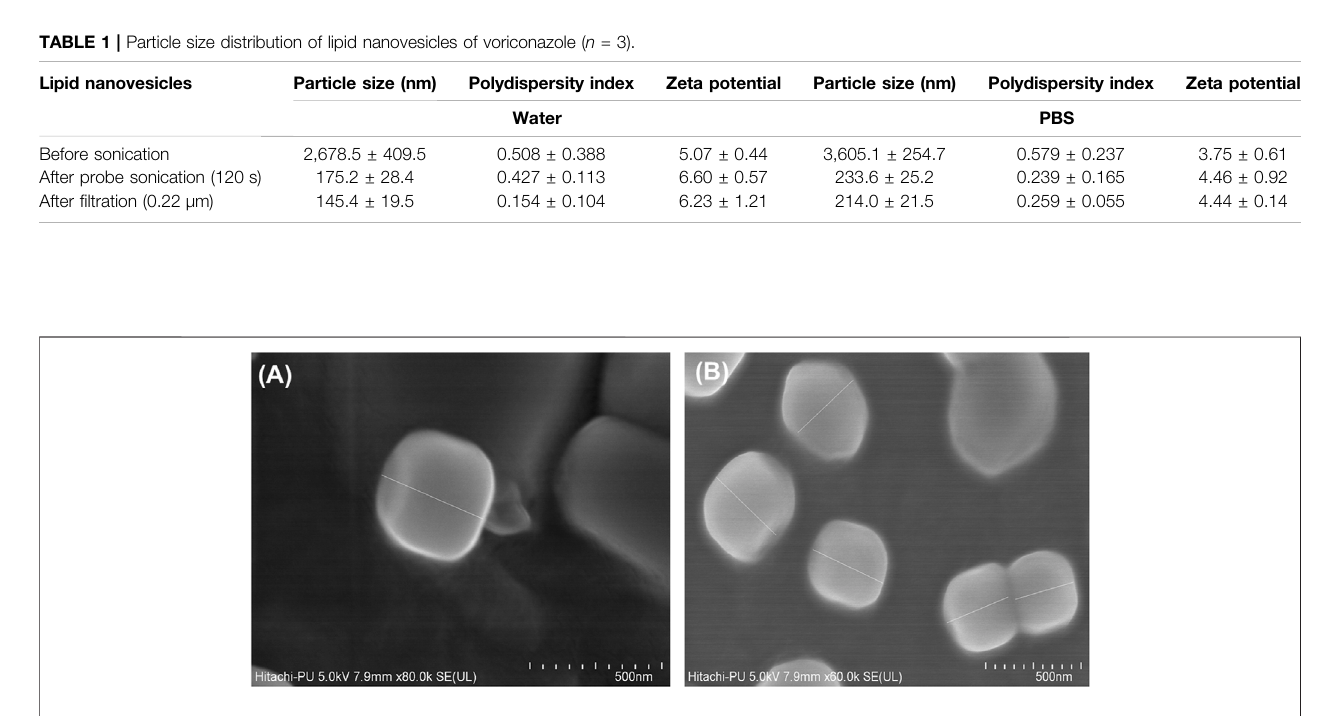
FIGURE 1 | Representative FESEM images of blank (A) and voriconazole-loaded nanovesicles (B) . The scale bar indicates 500 nm with a mean ( ± SD) size of 248.03 ( ± 49.16) nm, calculated using ImageJ software.